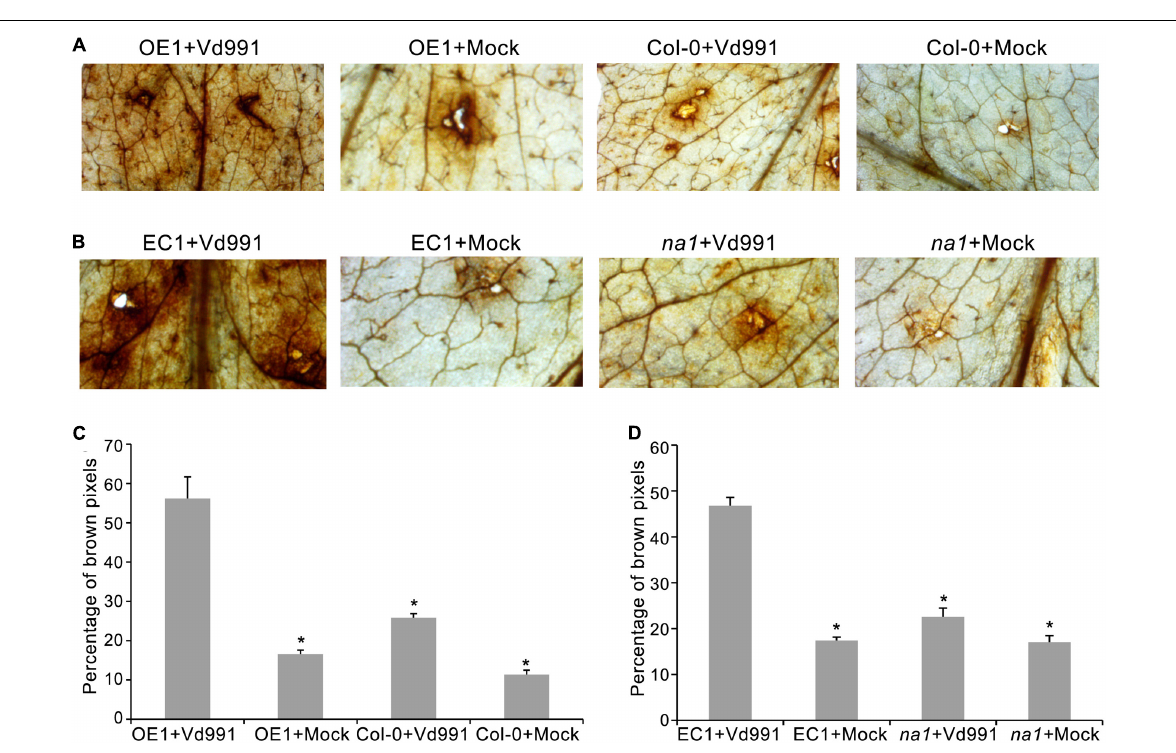
Frontiers in Plant Science |